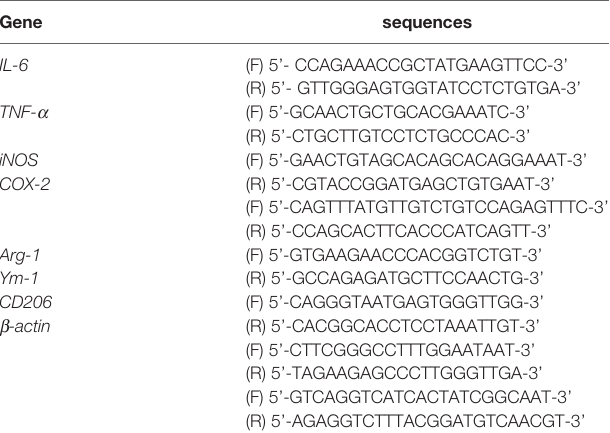
TABLE 1 | The primer sequences for